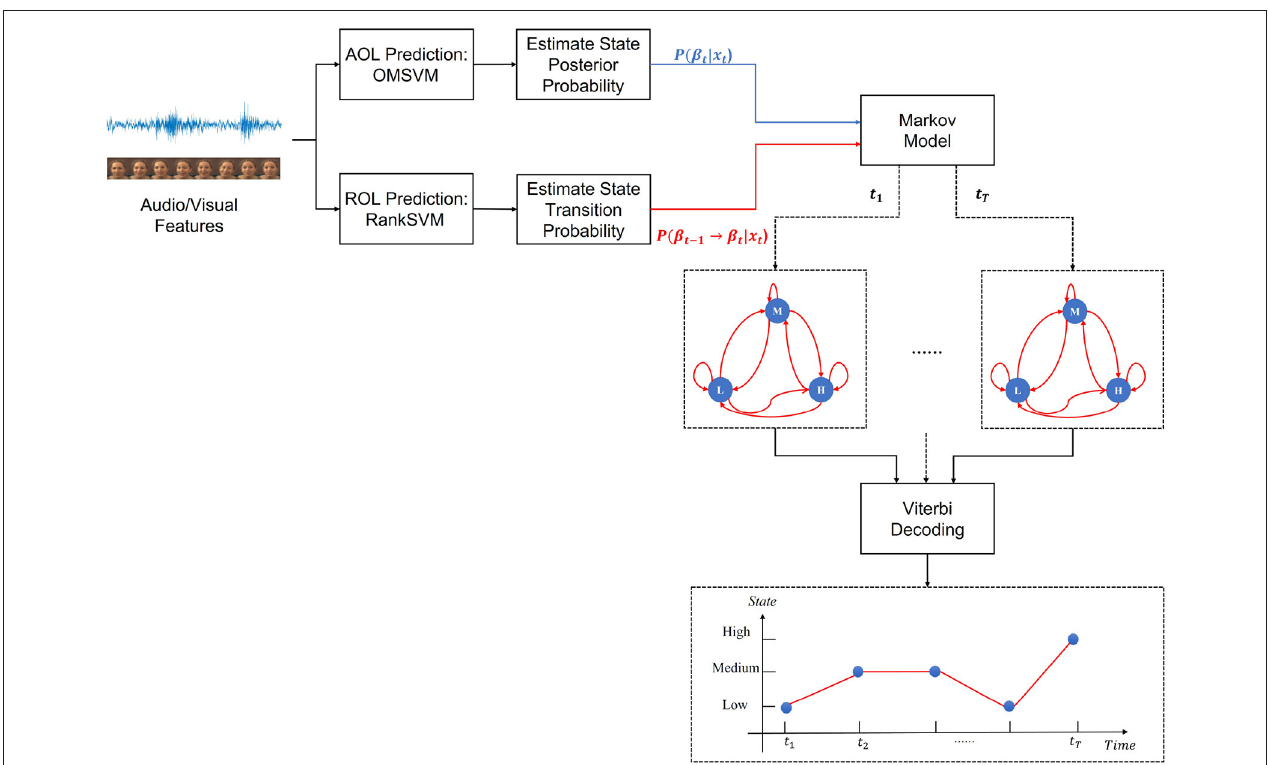
FIGURE 3 | Overview of the DOMM system architecture. In the depicted state diagrams, the blue circles indicate the state (i.e., AOL) with low (L), medium (M) and high (H) and red arrows denote the state transitions. The state posterior probability corresponding to the blue dots are calculated from AOL Prediction subsystem for each state L,M,H at each time step. Similarly, the state transition probability is obtained from the ROL prediction subsystem for all possible state transitions. The predicted emotion state sequence is then obtained using Viterbi decoding based on the time-varying state and transition probabilities. The x axis represents the time step from t 1 to t T . The y axis represents the AOLs with low (L), medium (M) and high (H) states. Red line indicates the “best path” after Viterbi tracking which gives the final predicted AOL sequence.